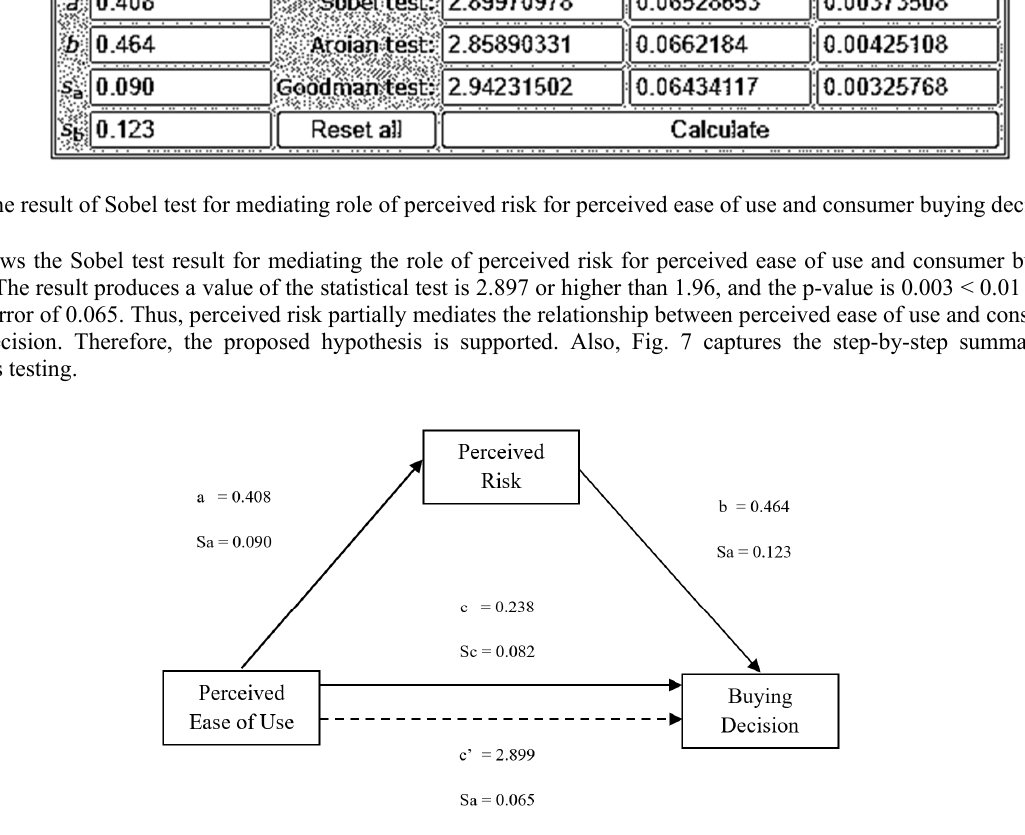
Fig. 6. The mediating role of perceived risk in the relationship between perceived ease of use and consumer buying